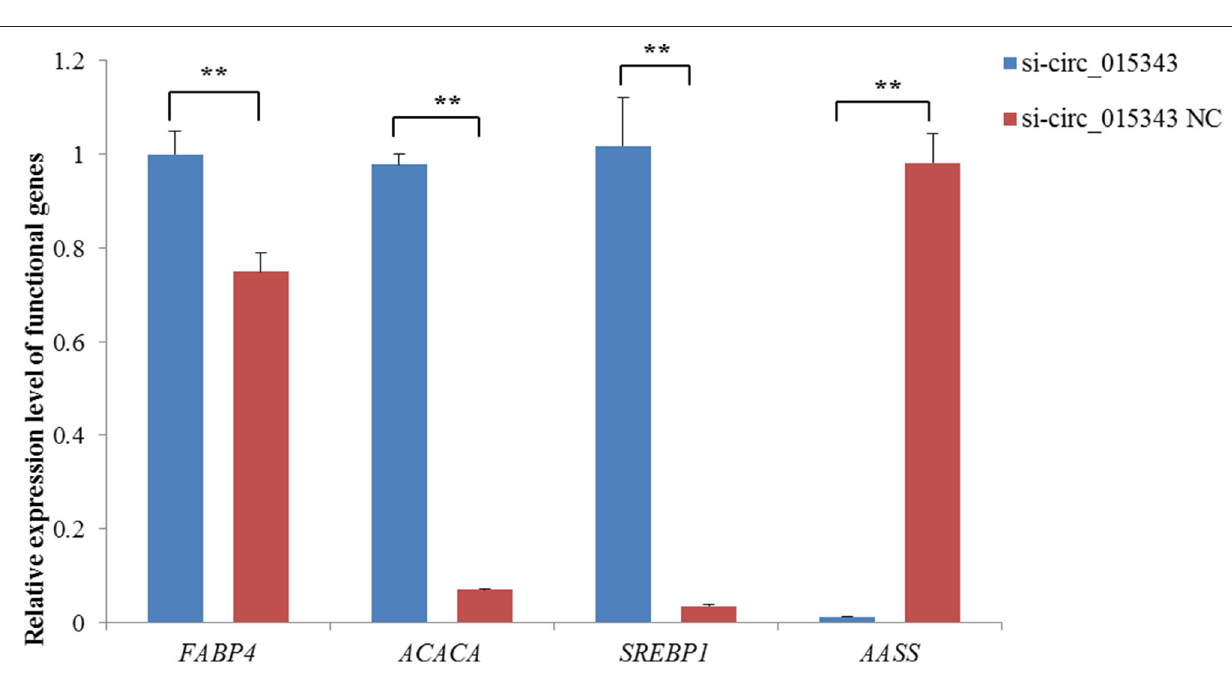
FIGURE 6 | Relative expression levels of functional genes when si-circ_015343 was transfected into ovine mammary epithelial cells. ** p <